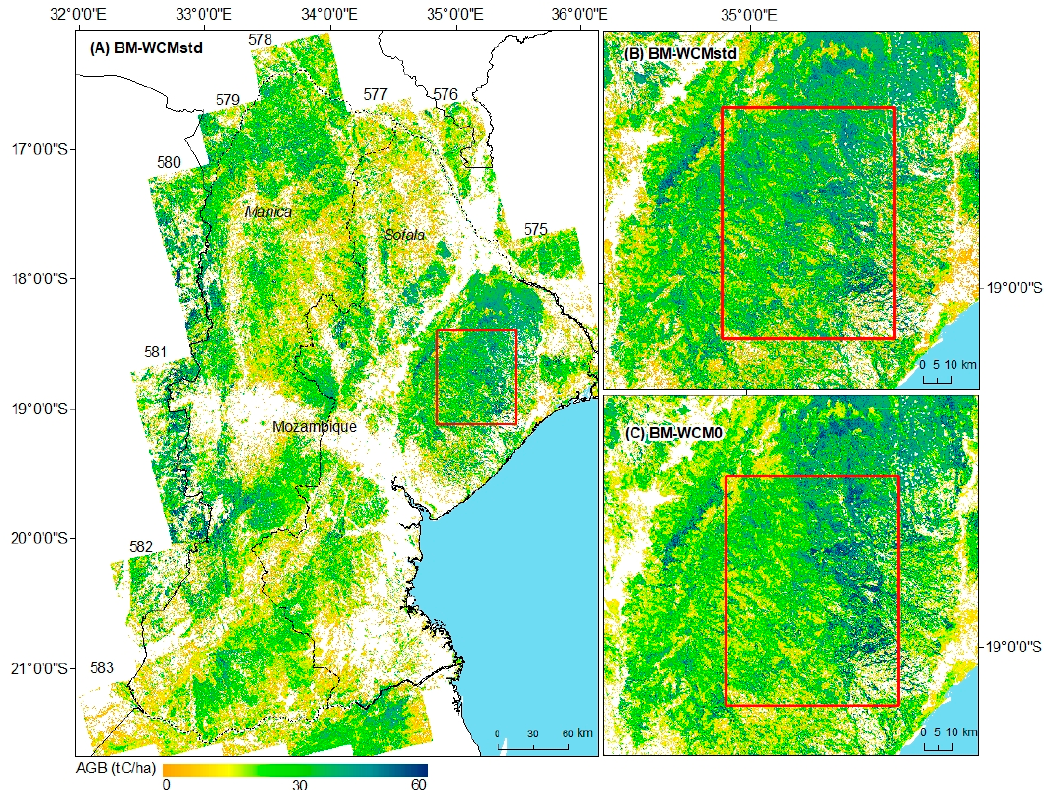
Figure 8. Regional AGBC maps created using BM-WCM std ( A ), with a comparison of the de-stripping effects between BM-WCM std ( B ) and BM-WCM 0 ( C ) in an enlarged view in the insets.